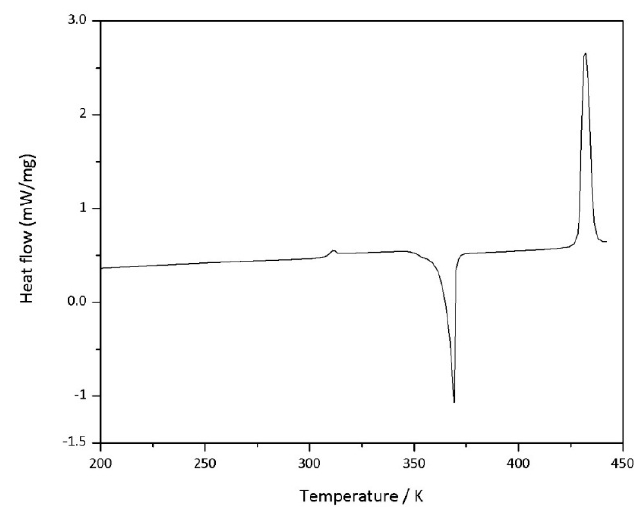
Figure 8. Second DSC scan from (EtPh 3 P) 2 [CuBr 4 ] ( 7 ).